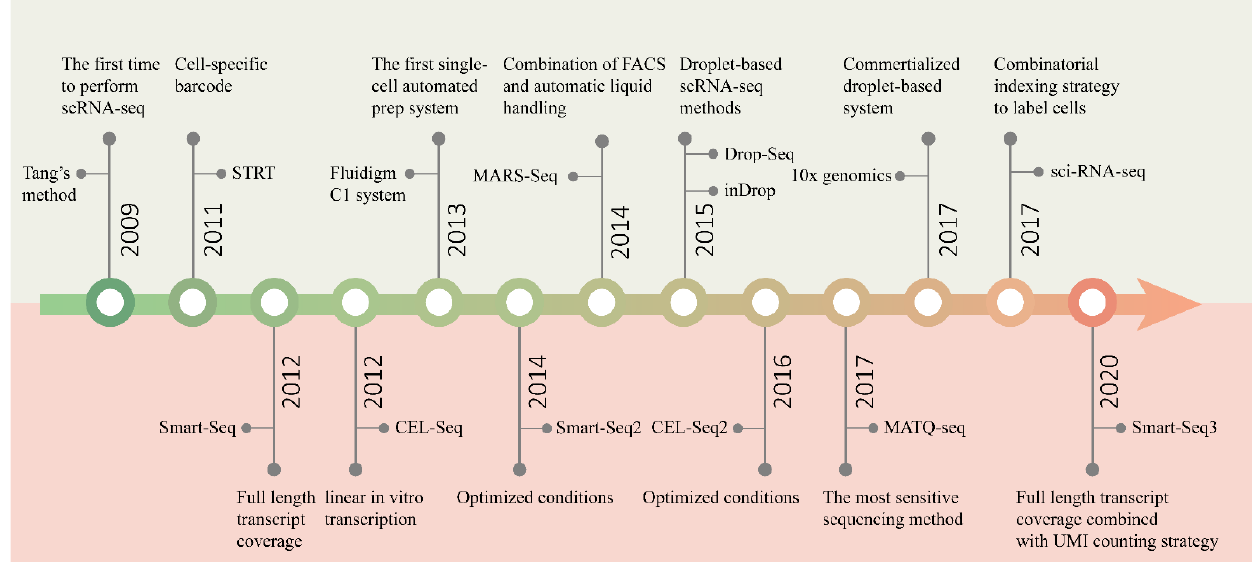
Figure 2. Timeline of the development of scRNA-seq technology. The upper half of the graph shows the main events marking the development of sequencing throughput, and the bottom half the improvement in